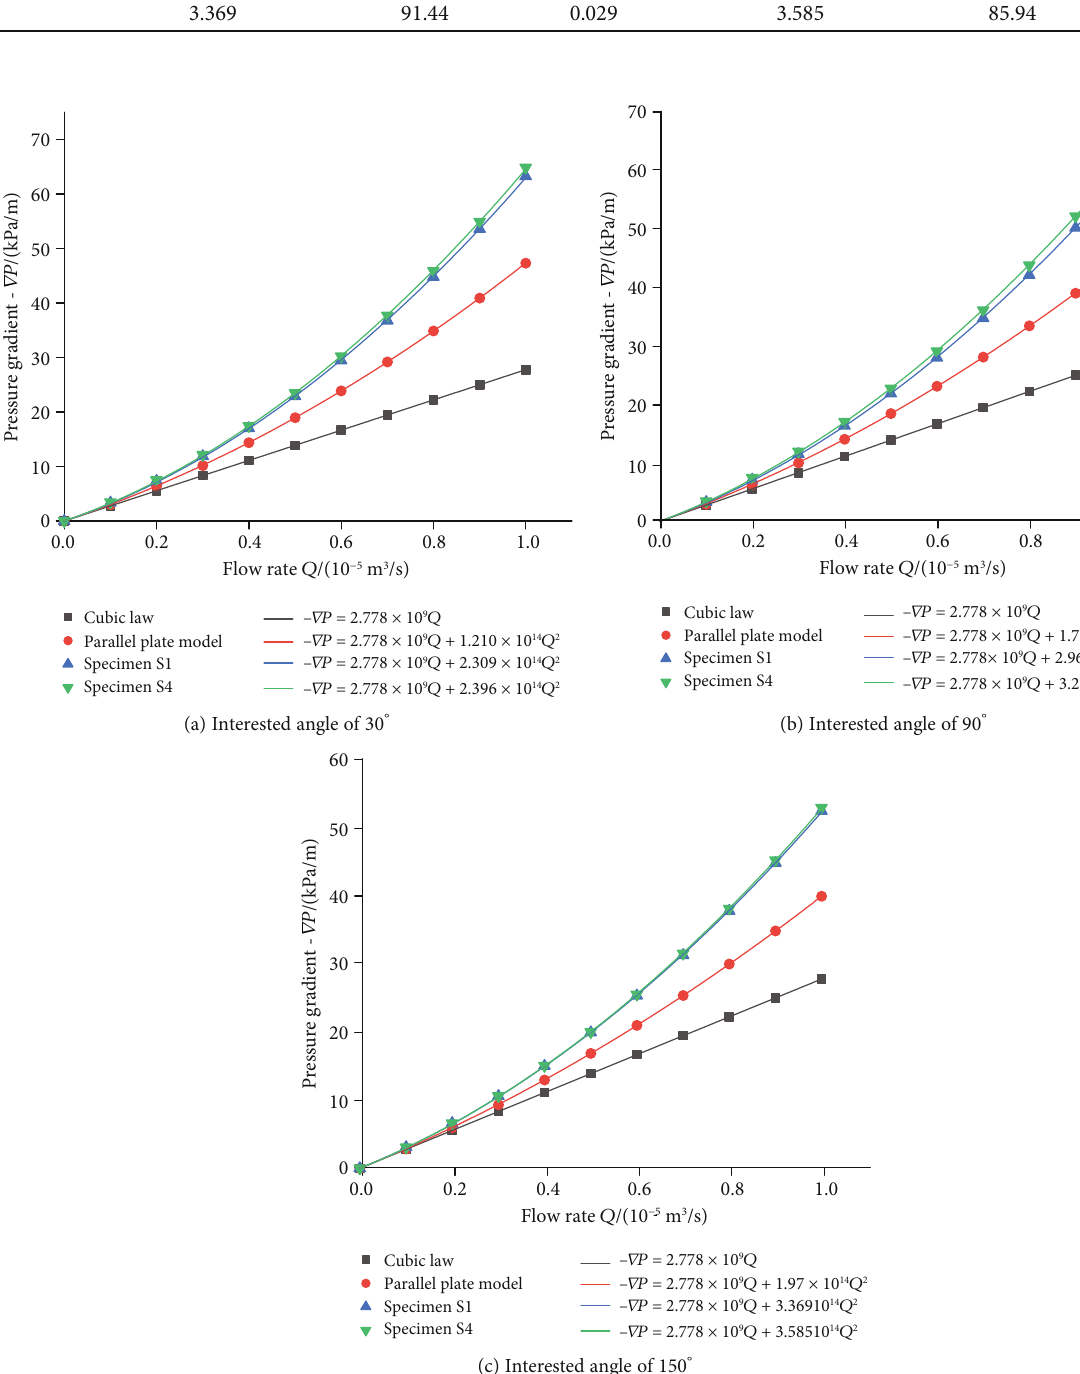
Figure 23: Curves of ∇ P ~ Q for rough fractures with di ff erent interested